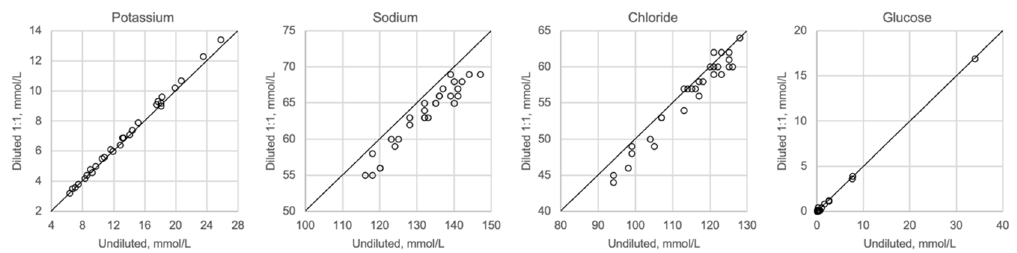
Figure 5. Comparison of undiluted and diluted samples, n = 29.